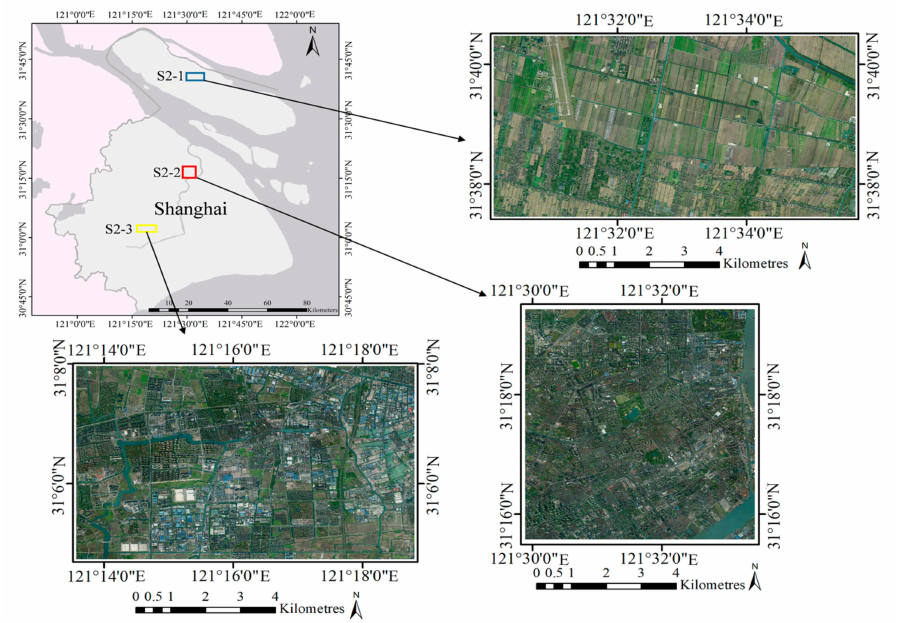
Figure 5. Study areas and image data of the Shanghai dataset.